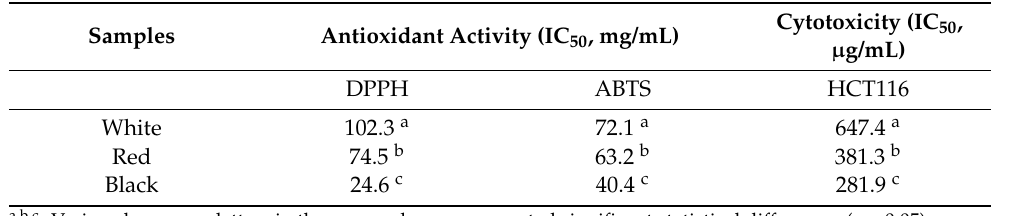
Table 3. Antioxidant activity and anticancer properties of three types of Chenopodium quinoa Wild seed